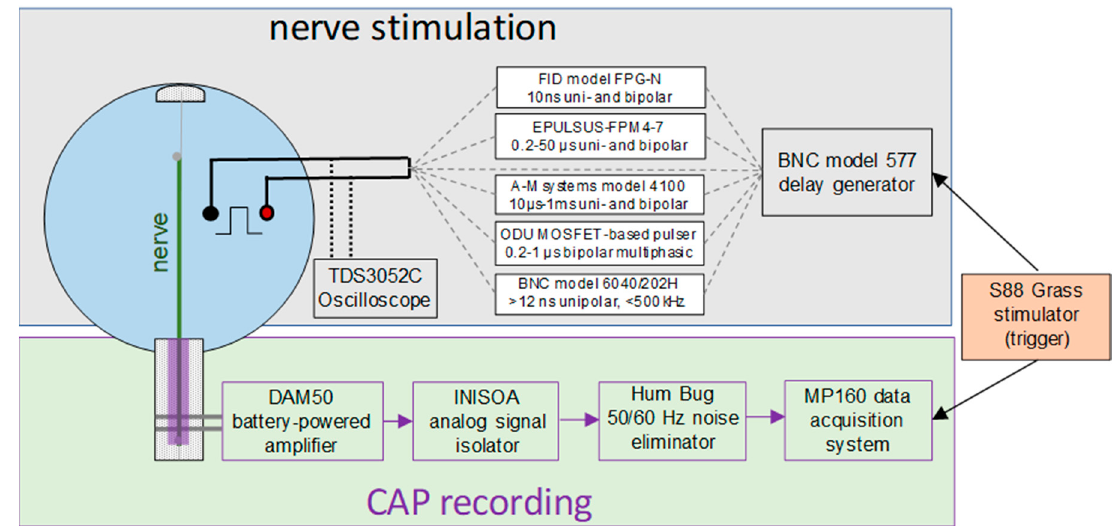
Figure 8. A block diagram of the devices for nerve stimulation ( top ) and recording of the compound action potential ( bottom ). The S88 Grass stimulator on the right triggered both the stimulation and acquisition. BNC model 577 enables the additional control of different pulse generators connected to stimulating electrodes. See text for more details.